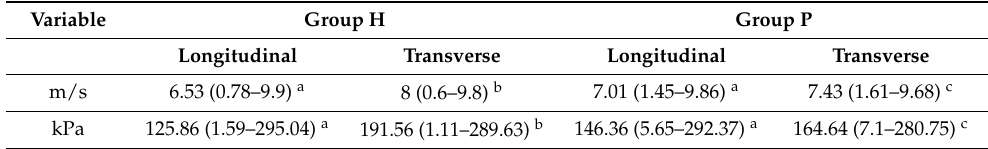
Table 2. Velocity (m/s) and Young’s modulus (kPa) in Group S and Group P in longitudinal and transverse scans. Values are expressed as median and range. Statistical significance was set at p <